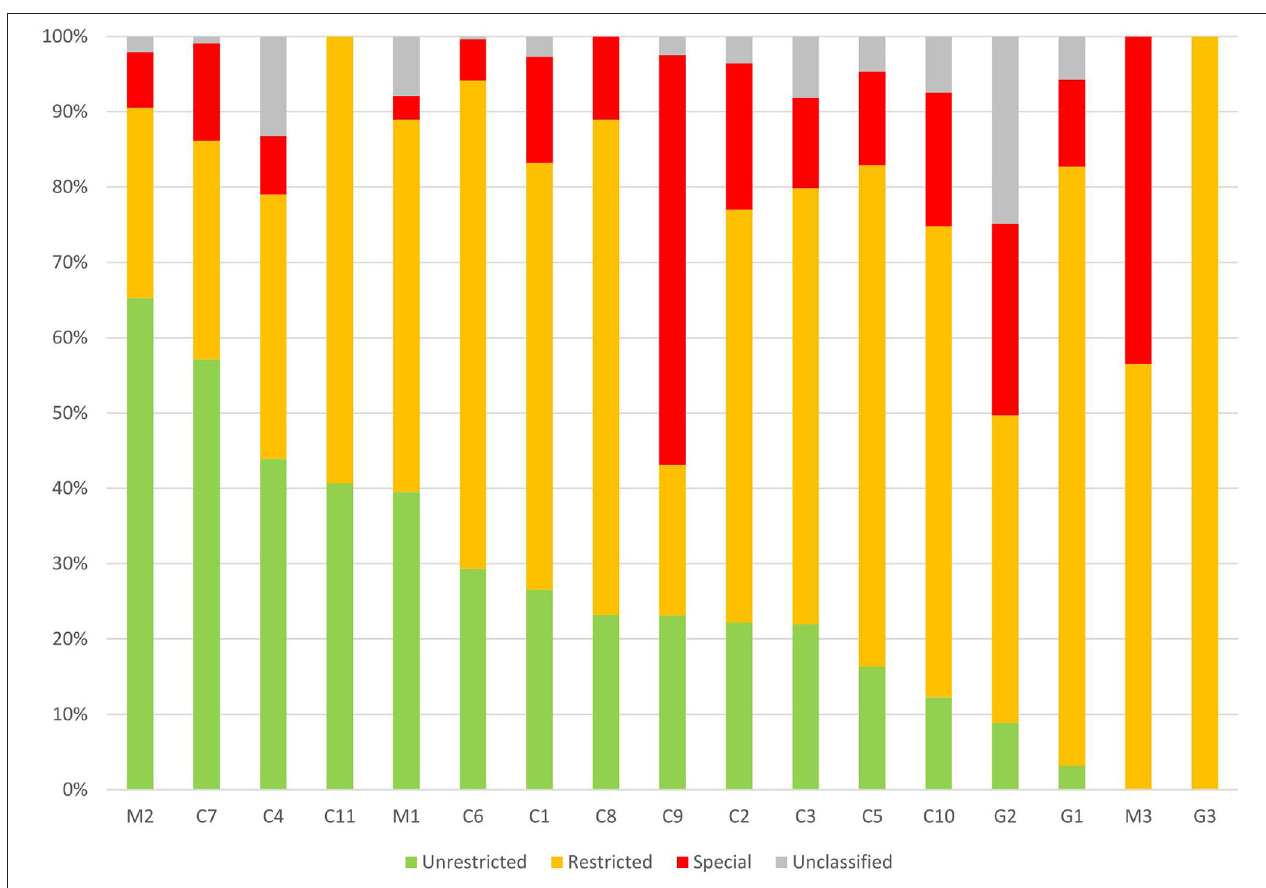
FIGURE 4 | Patterns of Unrestricted, Restricted, Special antibiotics prescribed for children from different hospitals in China. C, children’s hospital; M, maternal and children’s; and G, general hospital.